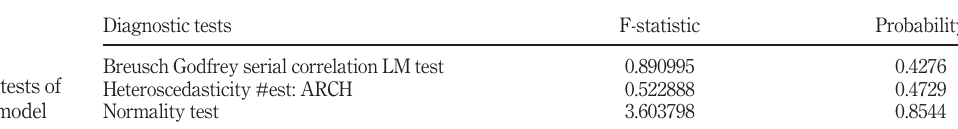
Table 6. Diagnostic tests of the ARDL